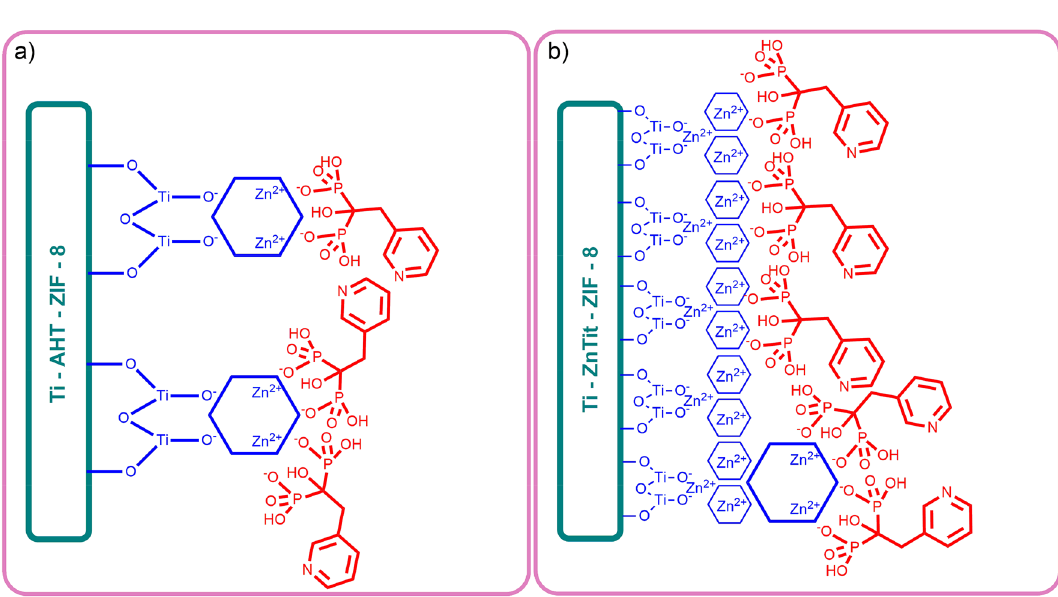
Figure 8. Potential scheme of drug adsorption on the surface of alloys modified with two